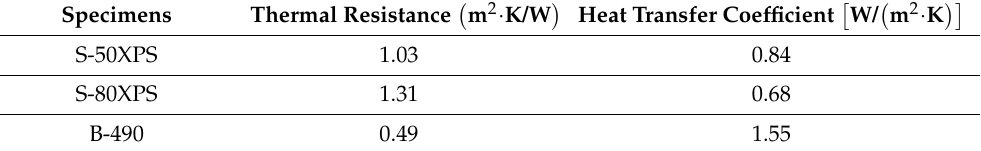
Table 1. Thermal resistance and heat transfer